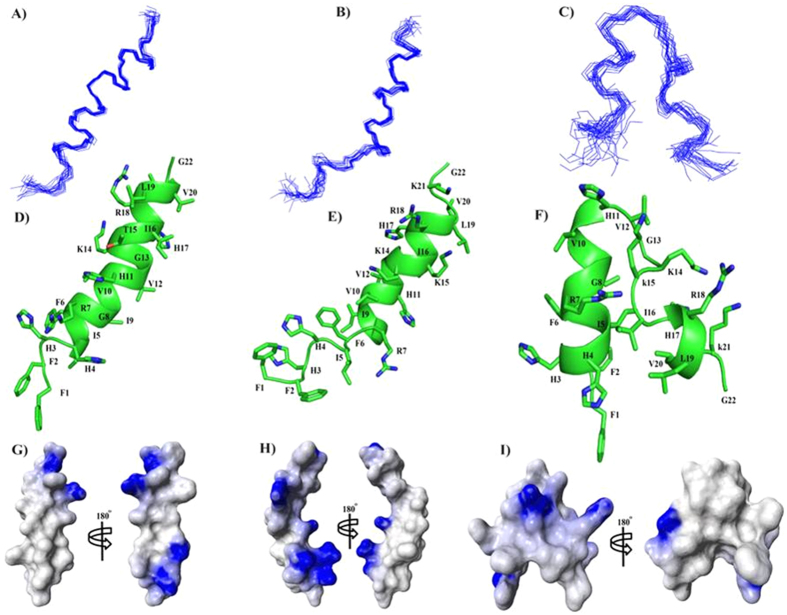
Superposition of twenty lowest energy structures of piscidin-1 (panel A), T15,21K-piscidin-1 (panel B) and T15,21dK-piscidin-1 (panel C) calculated using CYANA. Ribbon representations of a selected structure of piscidin-1 (panel D), T15,21K-piscidin-1 (panel E) and T15,21dK-piscidin-1 (panel F) showing backbone and sidechain orientation. Electrostatic surface diagrams of piscidin-1 (panel G), T15,21K-piscidin-1 (panel H) and T15,21dK-piscidin-1 (panel I) showing distribution of cationic charges (in blue) and non-polar residues (in white).